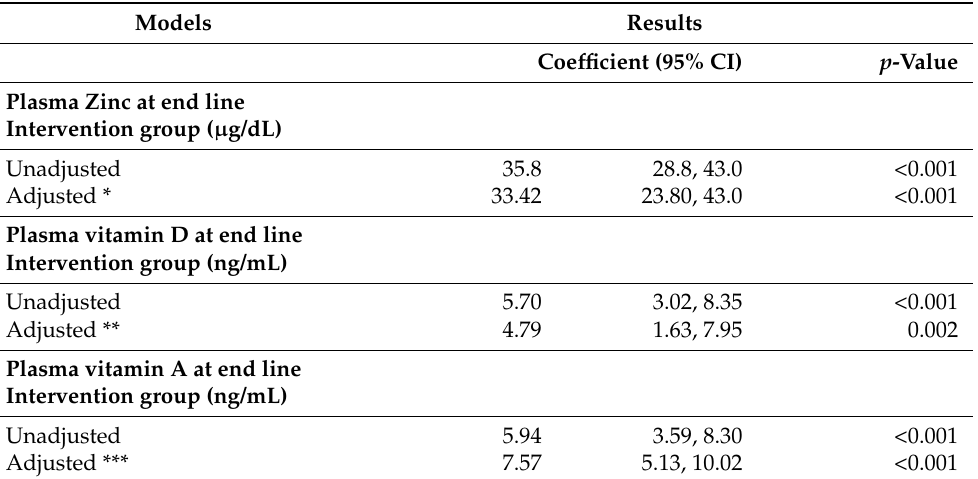
Table 5. Multiple linear regression analysis of the plasma zinc, vitamin A, vitamin D, and hemoglobin against nutritional outcomes by the group during the course of the